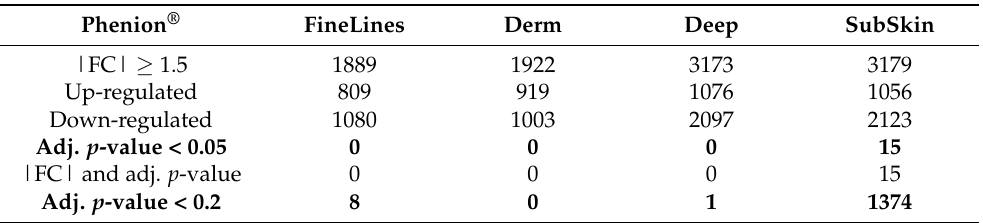
Table 2. DEGs for the Phenion ® Full-Thickness Skin model exposed to Perfectha ® fillers. The number of genes significantly different compared to non-treated control cells is indicated in